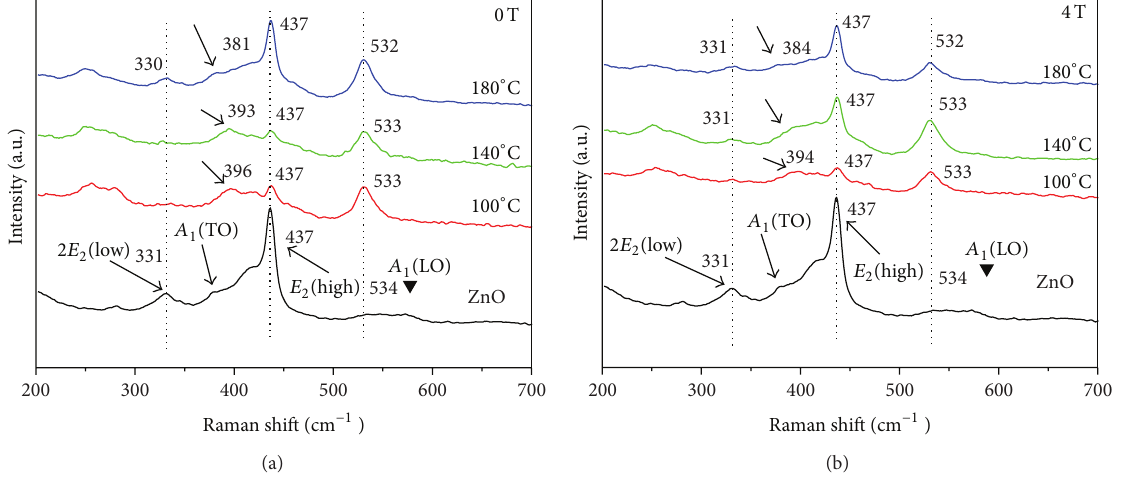
Figure 5: The Raman spectra of the samples.